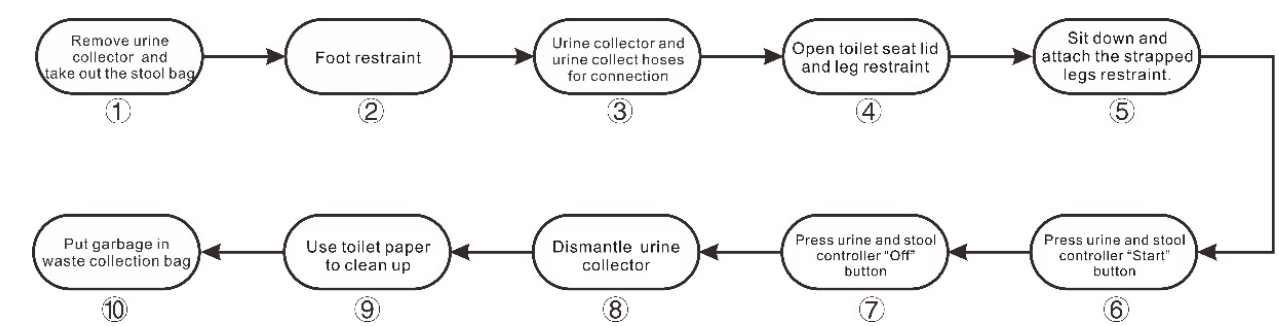
Figure 4. Hygiene area operating procedures .